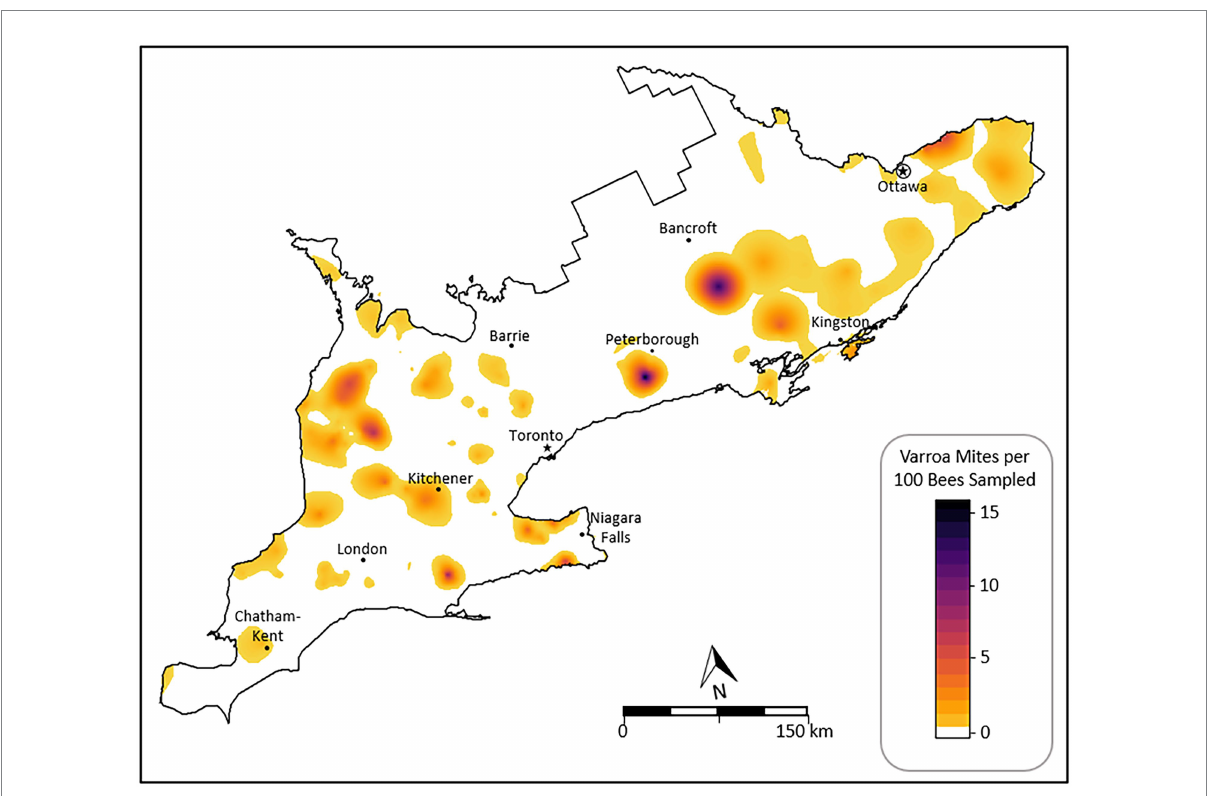
FIGURE 6 Isopleth map of predicted V. destructor rates for Southern Ontario derived from spatial regression